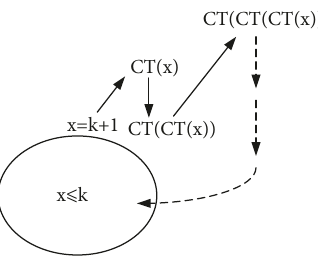
Figure 1: Induction rationale. Once current transformed number is less than the starting number, the starting number will be called “Returnable”. That is, once 𝐶𝑇(𝐶𝑇(... 𝐶𝑇(𝑥))) < 𝑥 , then 𝑥 ∈ RTN .